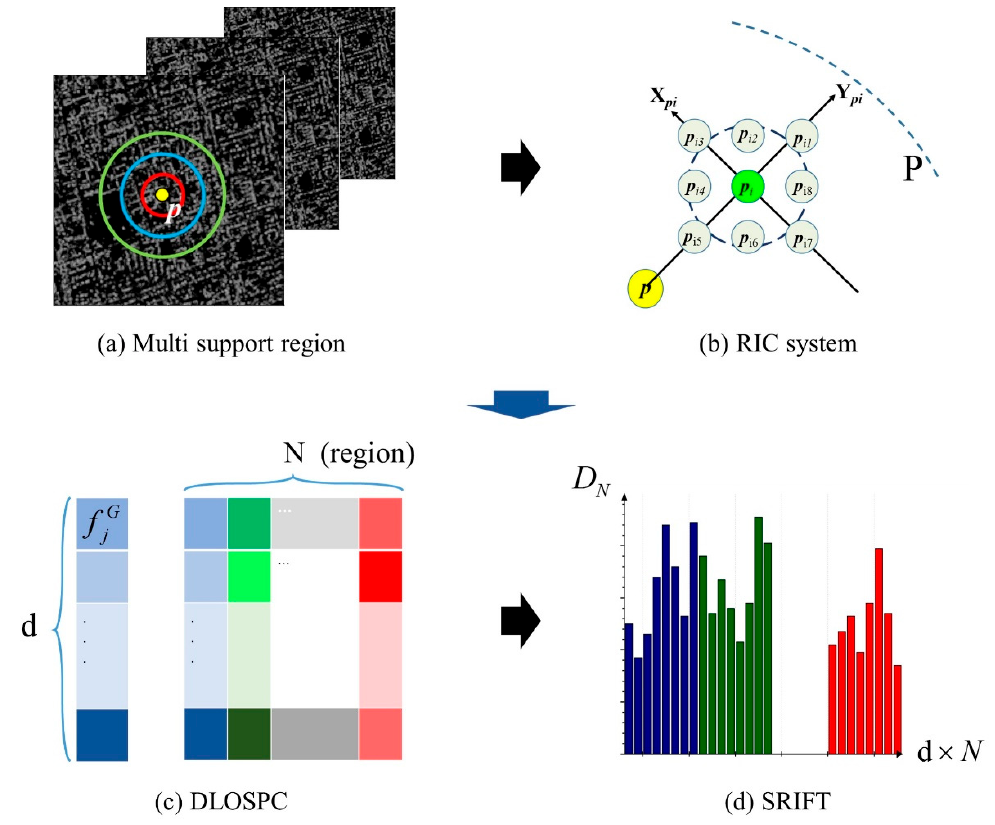
Figure 3. A flowchart of the construction of the descriptor. ( a ) Multiple supported regions. ( b ) Local RIC system. ( c ) difference between local orientation and scale phase congruency (DLOSPC). ( d ) Vectors of SRIFT.